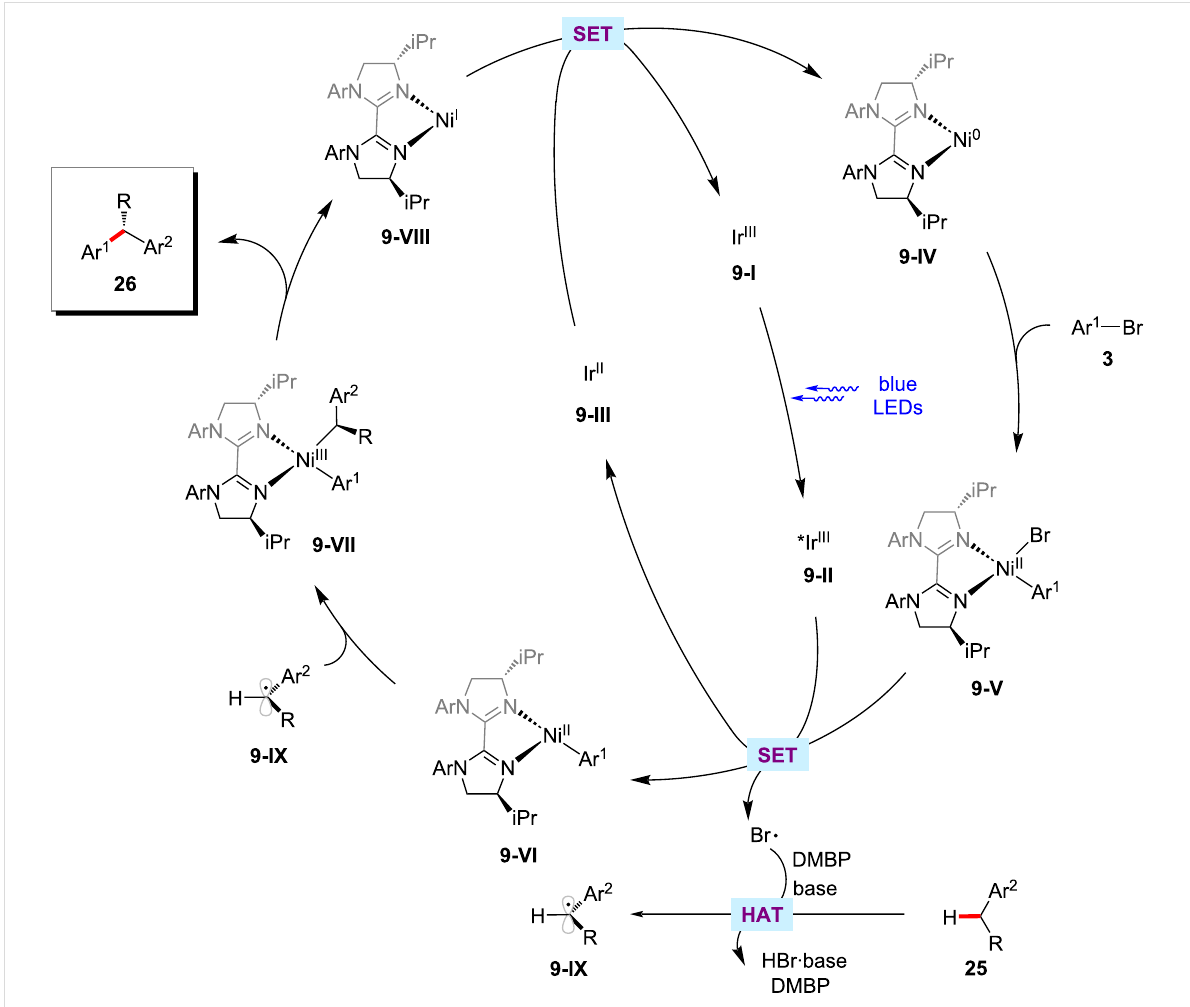
Figure 9: Proposed mechanism for the photoredox and nickel-catalyzed enantioselective benzylic C–H arylation.